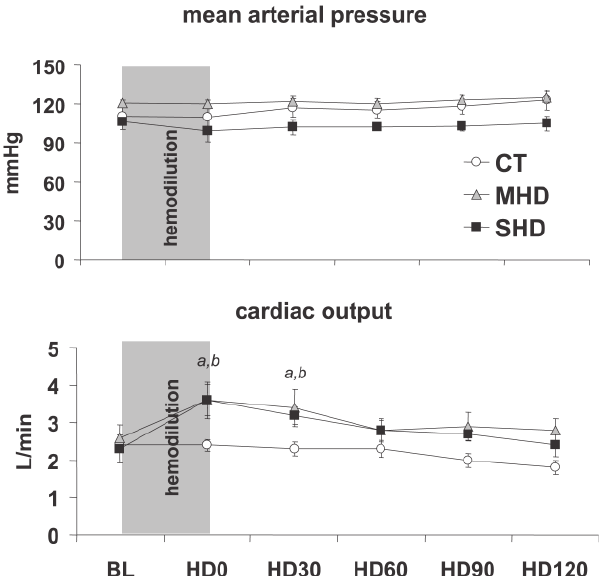
Figure 2 - ( A ) Mean arterial pressure during the experiment in the control (CT), moderate hemodilution (MHD), and severe hemodilution (SHD) groups. No significant changes between and within groups were observed. ( B ) Cardiac output during the experiment in the control (CT), moderate hemodilution (MHD) and severe hemodilution (SHD) groups. (a) MHD vs CT, P < 0.01; (b) SHD vs CT, P < 0.01.